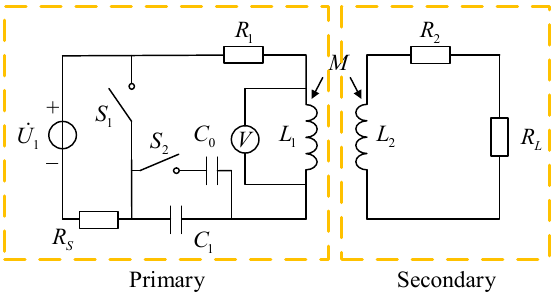
Figure 5. A passive wireless measurement system.